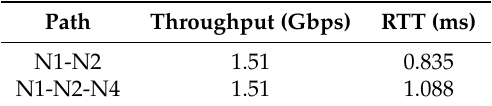
Table 2. Baseline latency and maximum throughput